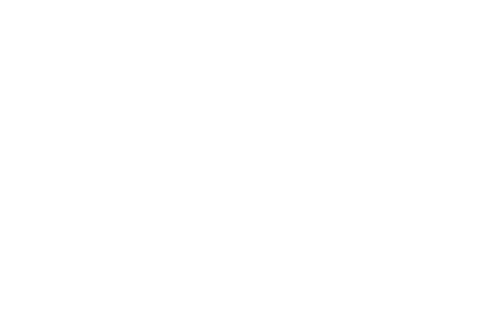
Table 3. Depth of penetration into the rat skin after application for 2 and 4.5 h.